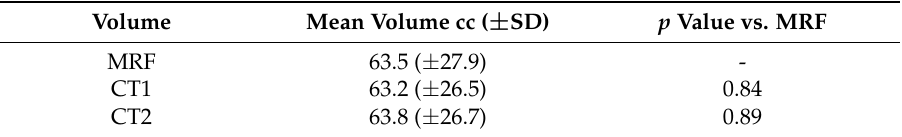
Table 2. CTV volumes.